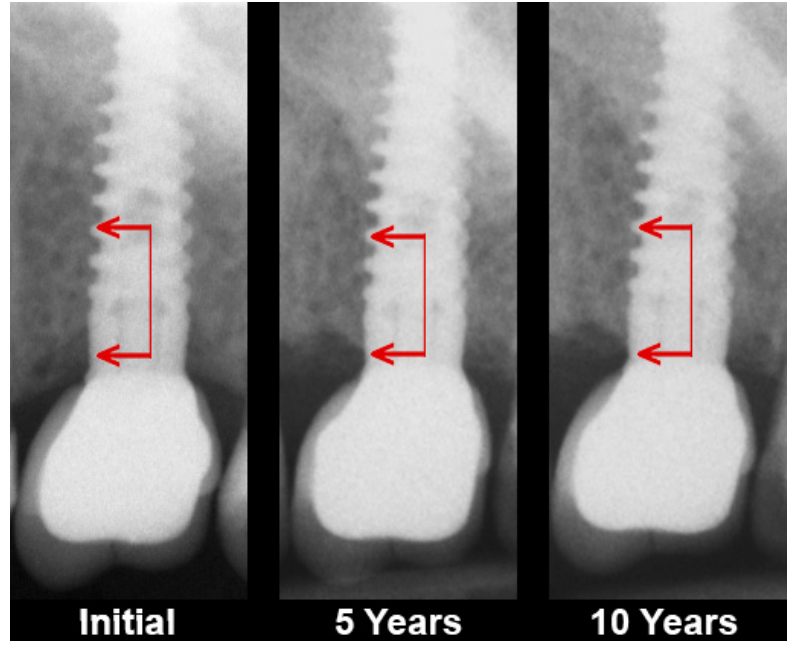
Figure 1. Example of marginal crestal bone alteration 5 and 10 years after the functional loading of a single dental implant by a crown. Bone level fluctuations and the transformation of bone tissue texture at the neck of the dental implant from cancellous to cortical can be seen (i.e., corticalization). The arrows show an example of the extent of peri-implant bone structure transformation.